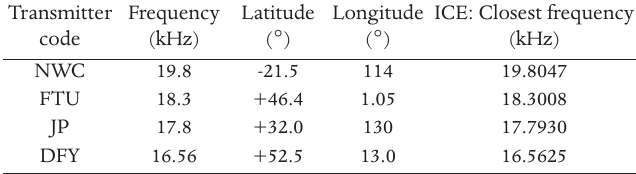
Table 1. Main features of the VLF stations and closest frequencies to the transmitter.